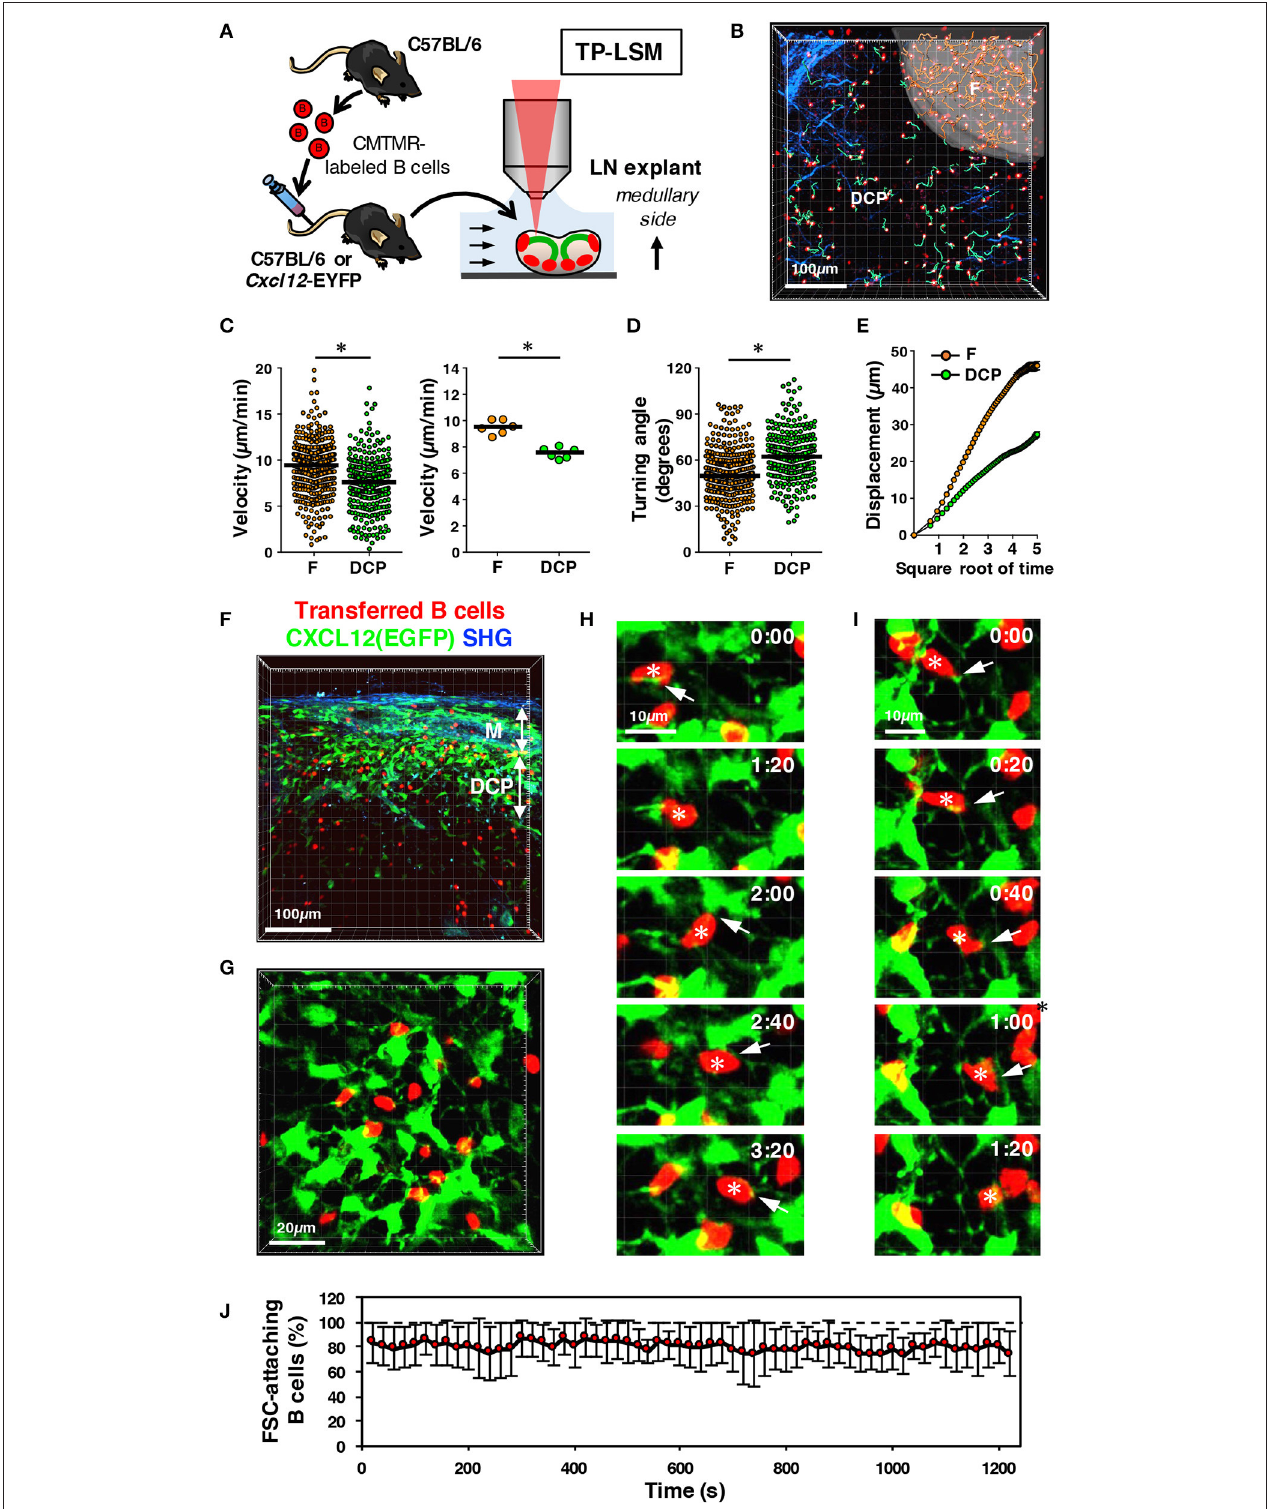
FIGURE 7 | Migration ability of DCP B cells interacting with DRC network in mouse LNs. (A) Schematic representation of experimental procedures. B cells isolated from wild type mice were labeled with CMTMR and transferred to recipient B6 or Cxcl12 -EGFP mice. After 24h, LN explants were examined with